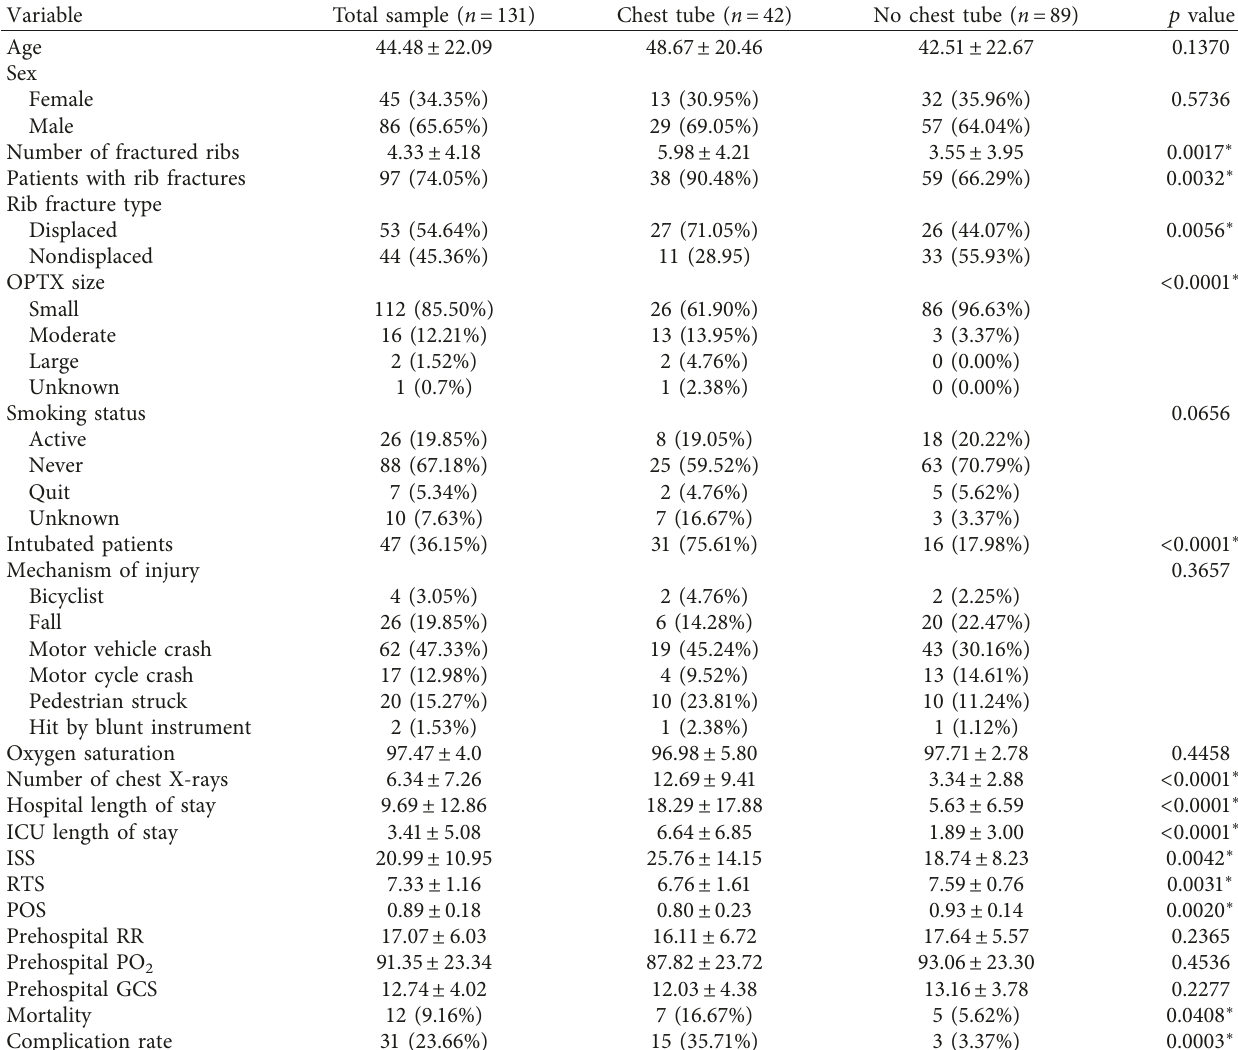
Table 1: Demographic and clinical characteristics of the study